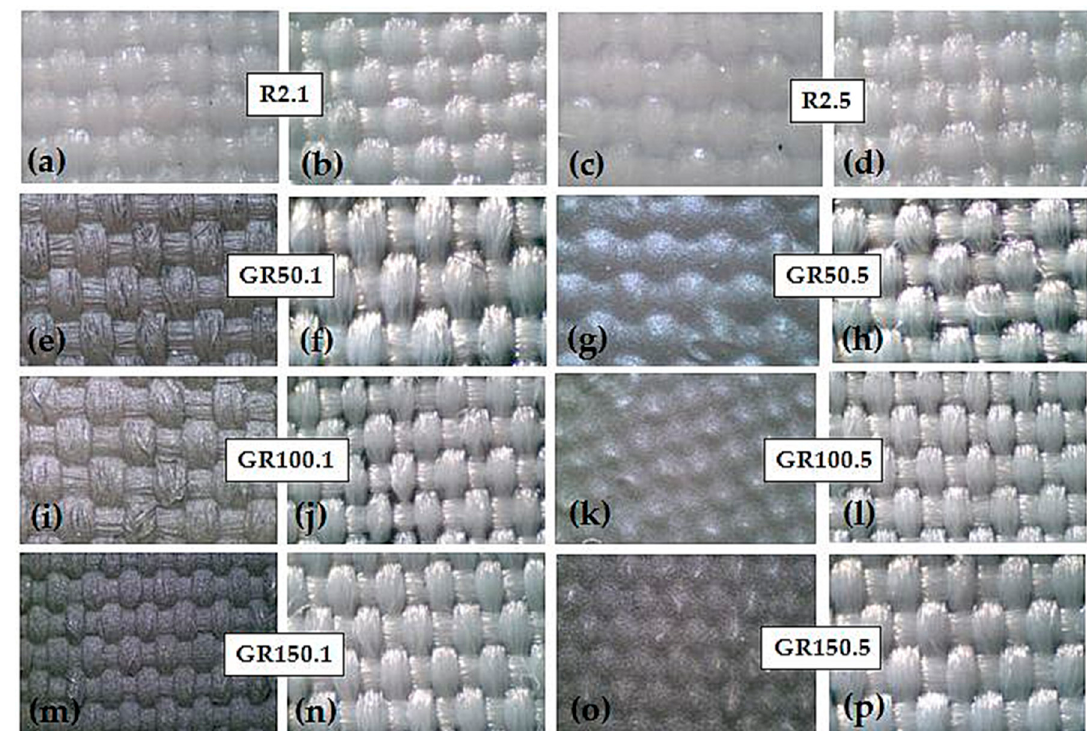
Figure 5. Front side images of fabrics ( a , c , e , g , i , k , m , o ) and reverse side images of fabrics ( b , d , f , h , j , l , n , p ).